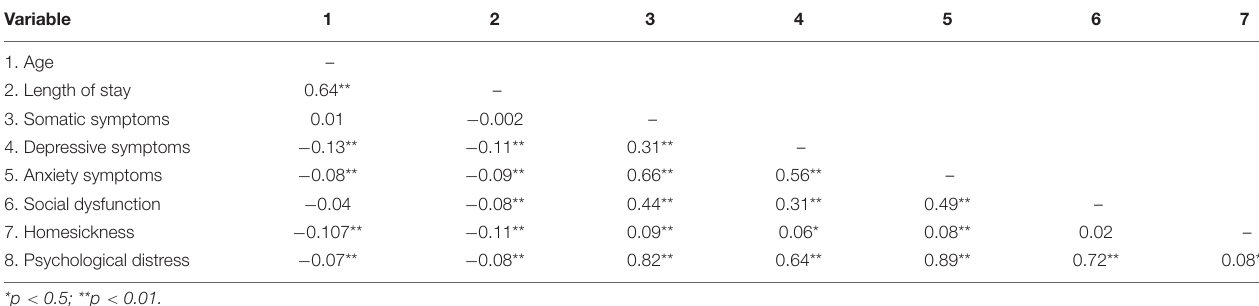
TABLE 1 | Intercorrelations between study variables.